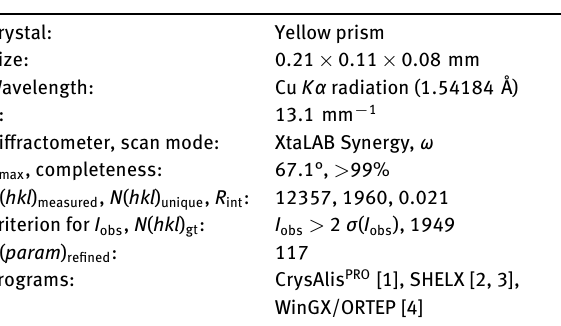
Table 1 contains crystallographic data and Table 2 contains the list of the atoms including atomic coordinates and dis- placement parameters. Table 1: Data collection and